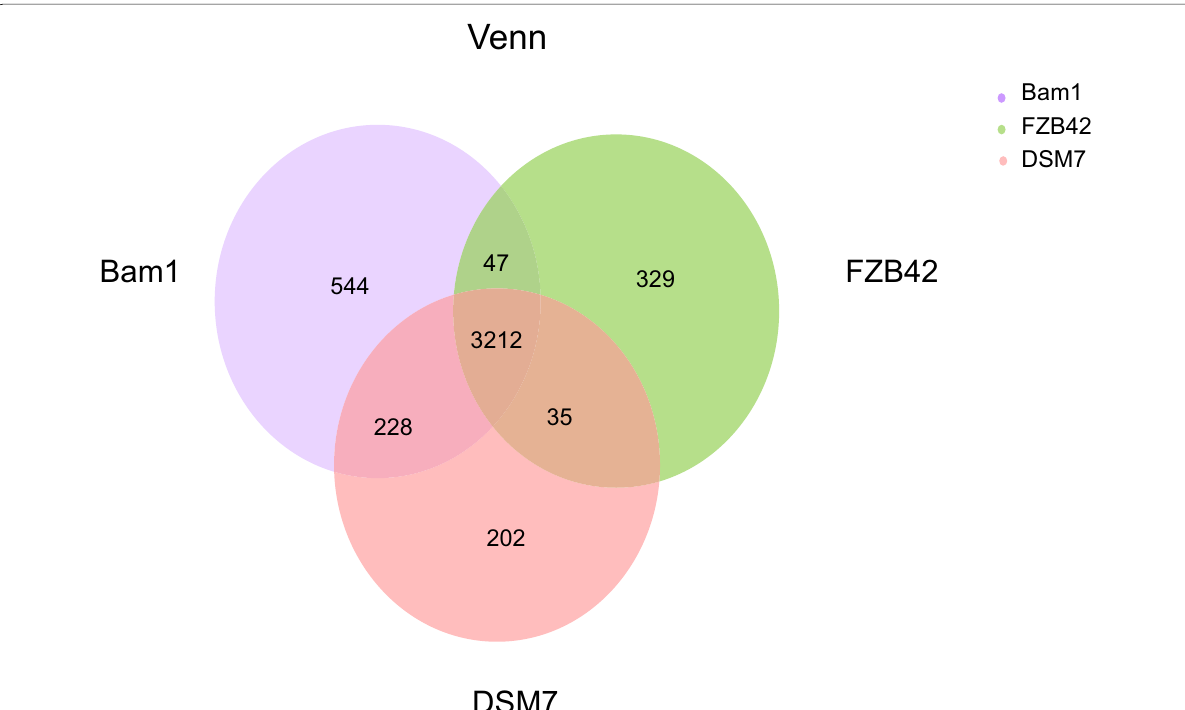
Fig. 5 Venn diagram showing numbers of specific and shared gene families among the B. amyloliquefaciens strains of Bam1and DSM7, as well as B. velezensis FZB42